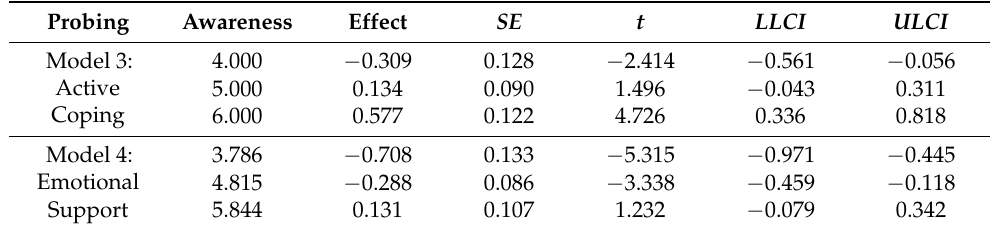
Table 5. Conditional effects of the focal predictor at values of the moderator(s) in Models 3 and 4.